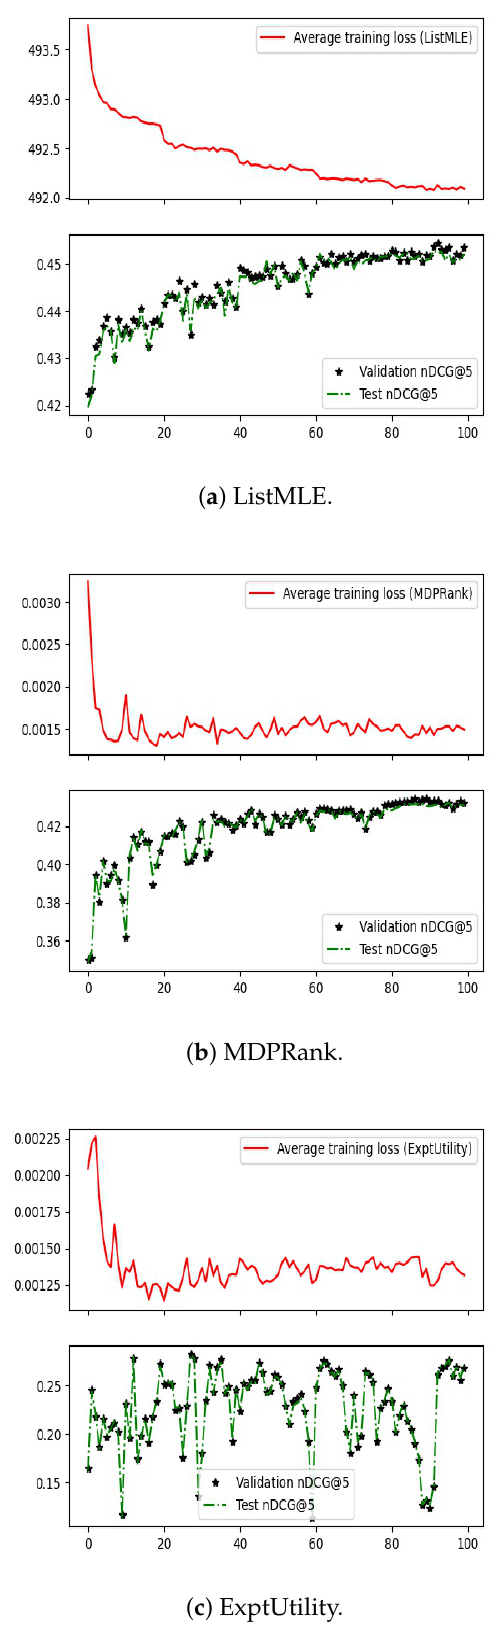
Figure 2. How the performance (nDCG@5) on the validation and test sets varies as the optimization on the train set progresses.